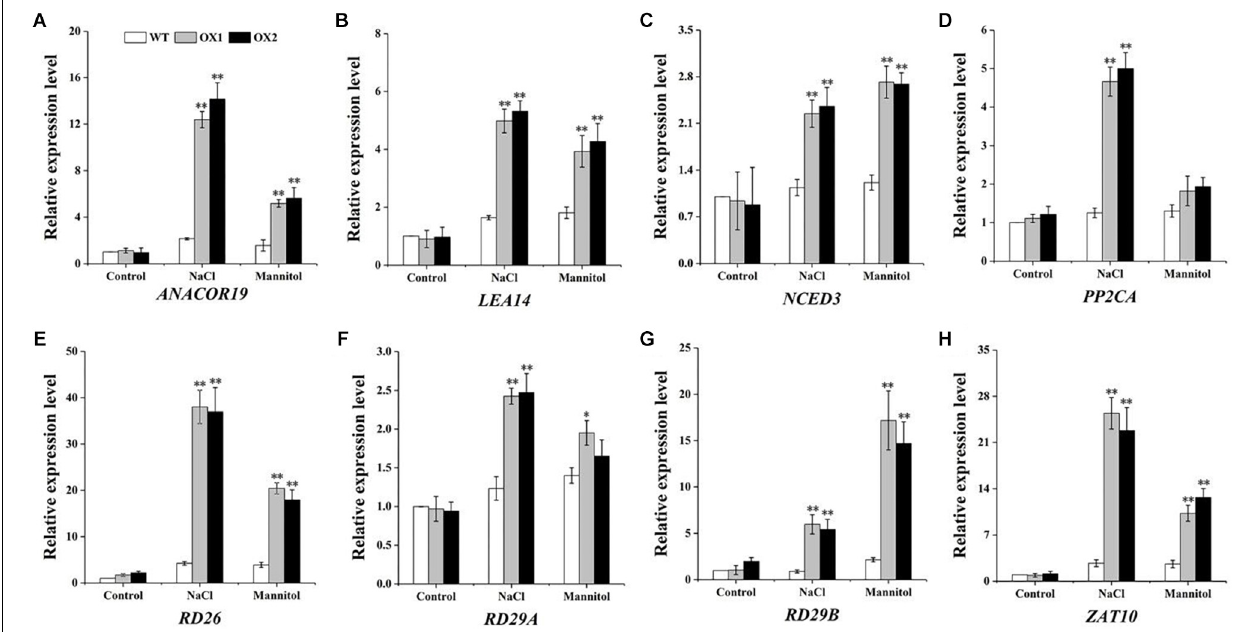
FIGURE 8 | Expression levels of the stress-associated genes in WT and OoNAC72 -OX plants. The 14-day-old seedlings grown on 1/2 MS medium were subsequently submerged in 1/2 MS cultures supplemented with 150 mM NaCl and 200 mM mannitol for 7 days. (A–H) Transcript levels of stress-associated genes were determined against with ACTIN8 . Data are means ± SD of three biological replicates. Asterisks indicates insignificant differences from WT ( ∗ P < 0.05; ∗∗ P < 0.01).